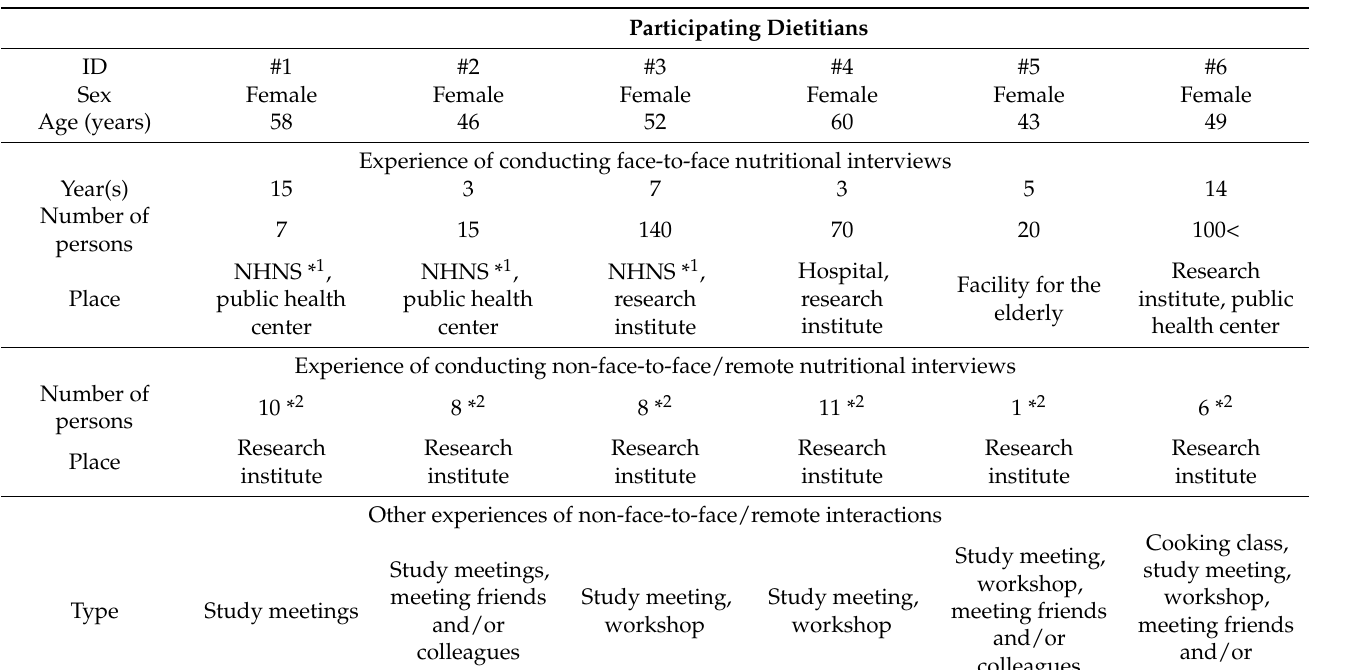
Table 2. Characteristics and interview experience of participating